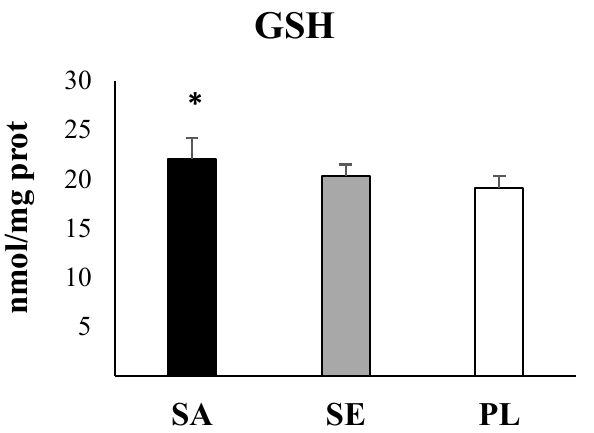
Figure 4. Activity of glutathione S -transferase (GST) in the digestive tract of H. tubulosa . Significant differences ( p -value < 0.05) are shown: * indicates differences respect to PL. SA, Sant Antoni de Portmany; SE, Santa Eulària des Riu; PL, Pou des Lleó.